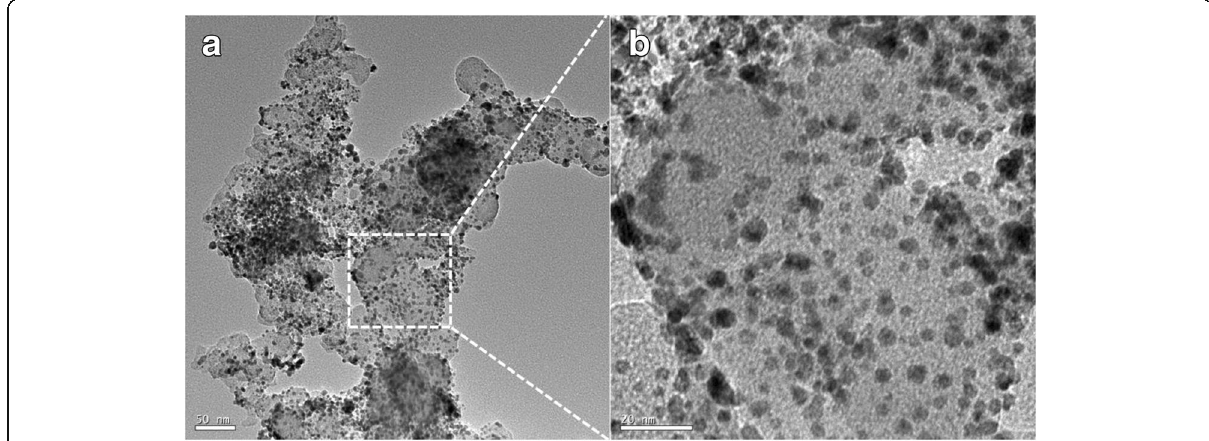
Fig. 1 a TEM image of the nanocatalyst, scale bar = 50 nm. b Zoomed-up TEM image, scale bar = 20